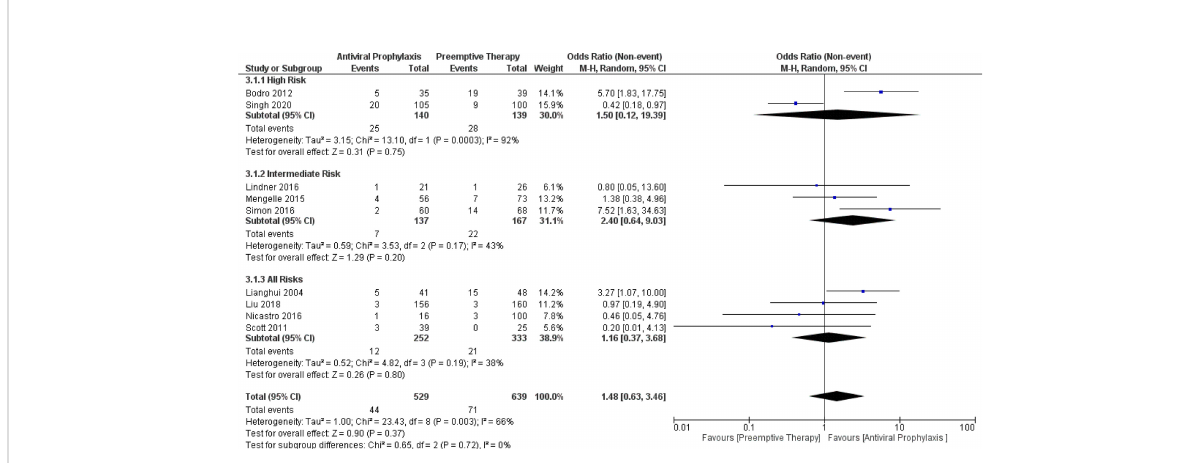
Figure 6) There was only one study reporting the incidence of graft loss in the high-risk group receiving antiviral prophylaxis (1.9%) and preemptive therapy (4%).9 Besides, the incidence of graft loss between antiviral prophylaxis and preemptive therapy was not signi fi cantly different: (OR: 2.15, 95% CI: 0.38, 11.98; p = 0.38) for the high-risk group, (OR: 0.61, 95% CI: 0.24, 1.54; p = 0.30) for the intermediate-risk group, and (OR: 0.56, 95% CI: 0.06, 5.01; p = 0.60) for the all-risks group. We found high heterogeneity among both the studies (Liu 2018 and Nicastro 2016) in the all-risks group. The test for the overall subgroup difference showed no heterogeneity (I 2 = 0%; p = 0.43) (Figure 8).